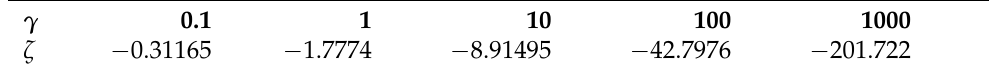
Figure 3. The power spectrum P ζ near the pivot scale k ∗ = k ∆ N Table 1. The parameters leading to the power spectrum in Figure 3 with ∆ N 2 ≈ 10.